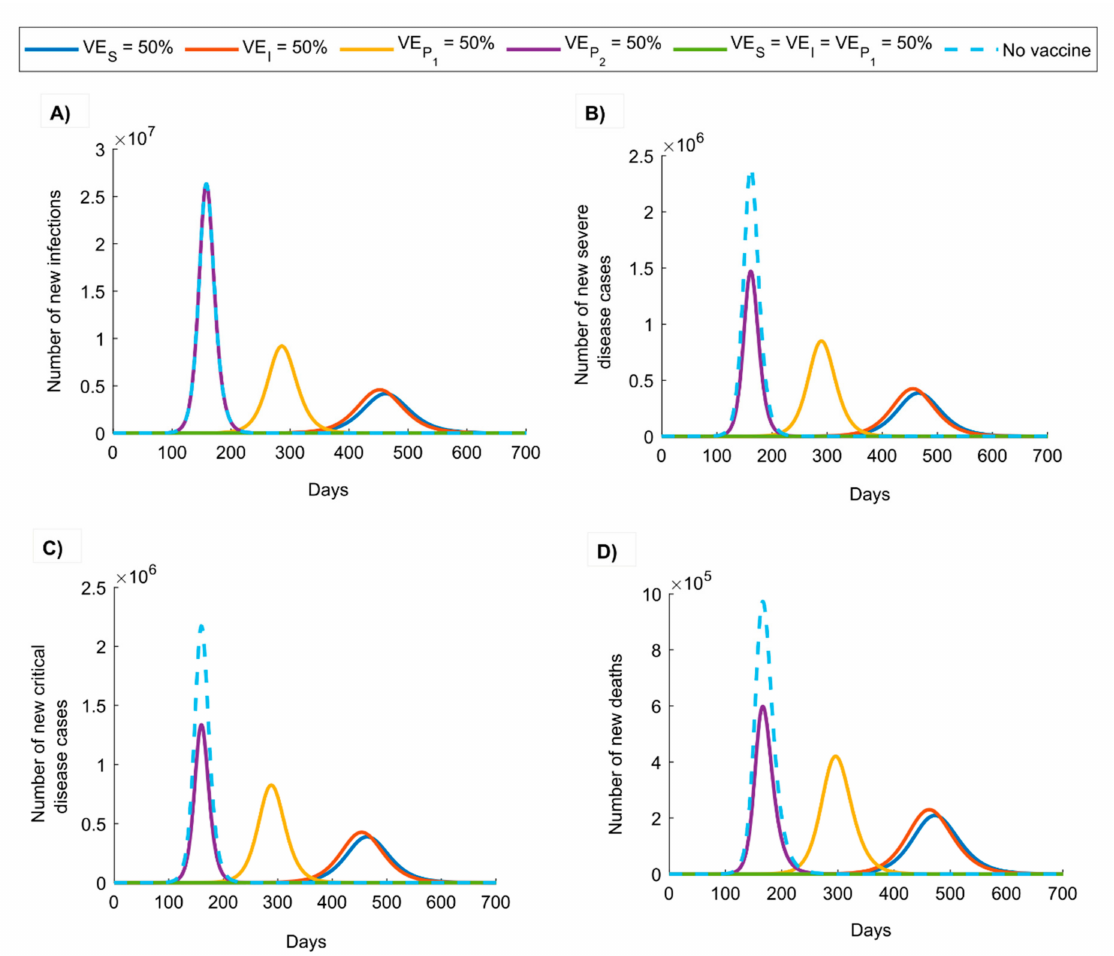
Figure 1. Impact of SARS-CoV-2 vaccination on the number of ( A ) new infections, ( B ) new severe disease cases, ( C ) new critical disease cases, and ( D ) new deaths in the scenario assuming vaccine scale-up to 80% coverage before epidemic onset. The duration of vaccine protection is 10 years. Impact was assessed at VE S = 50%, VE I = 50%, VE P